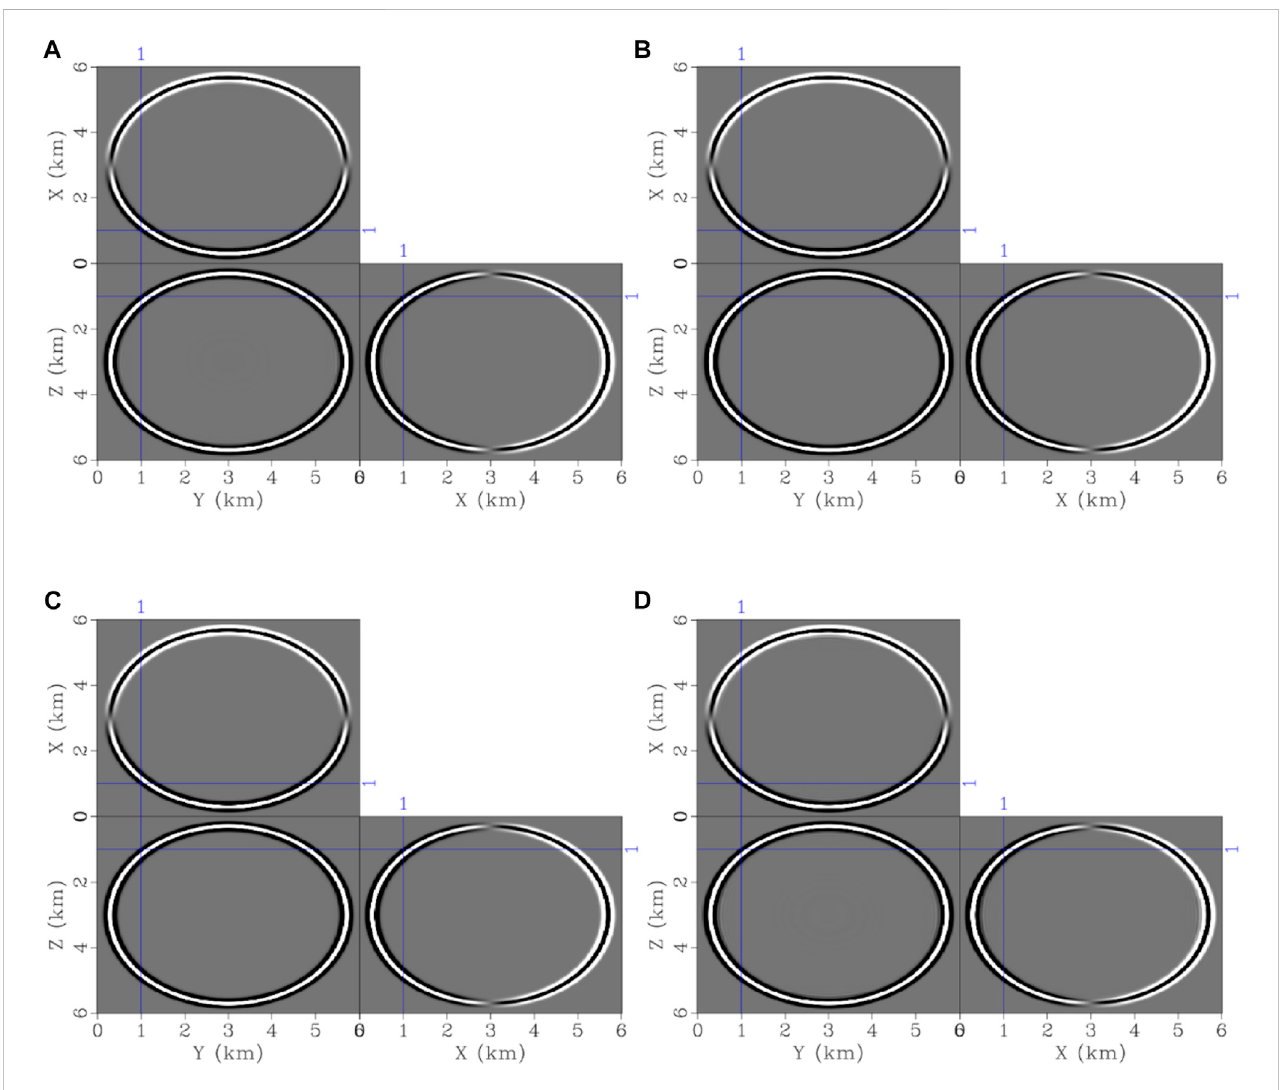
FIGURE 3 Wave fi eld snapshots v x obtained using FTS with the SGFD (A) fourth- and (B) sixth-order spatial SGFD accuracy and using the STS with the SGFD (C) fourth- and (D) sixth-order spatial SGFD accuracy. The wave fi eld snapshots are recorded at 0.96 s with a time step of 2.4-ms time marching for the FTS method and 0.6-ms time marching for the STS